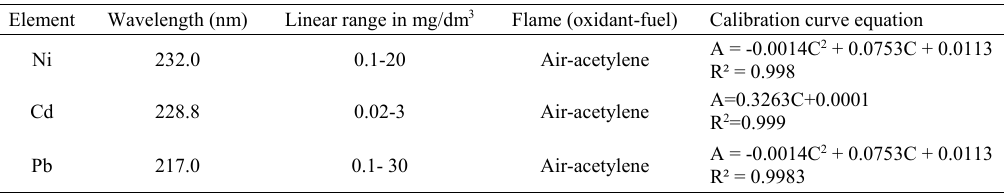
Table 1: Atomic absorption conditions in determination of heavy metal ions